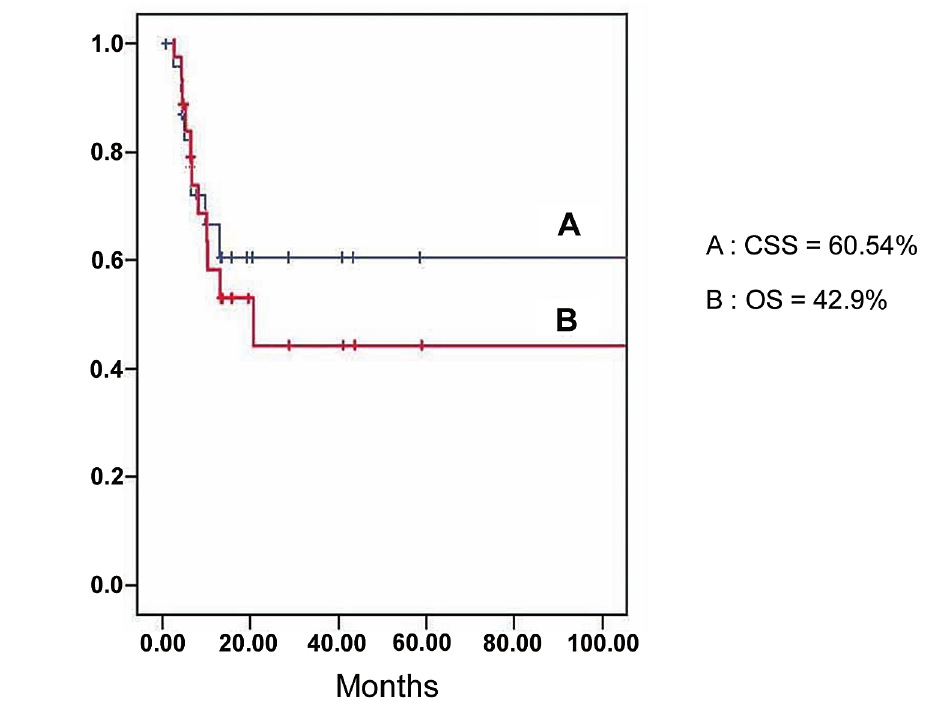
Figure 1 – Survival rates in radical cystectomy patients: A) Cancer-specific survival (CSS), B) Overall survival (OS).